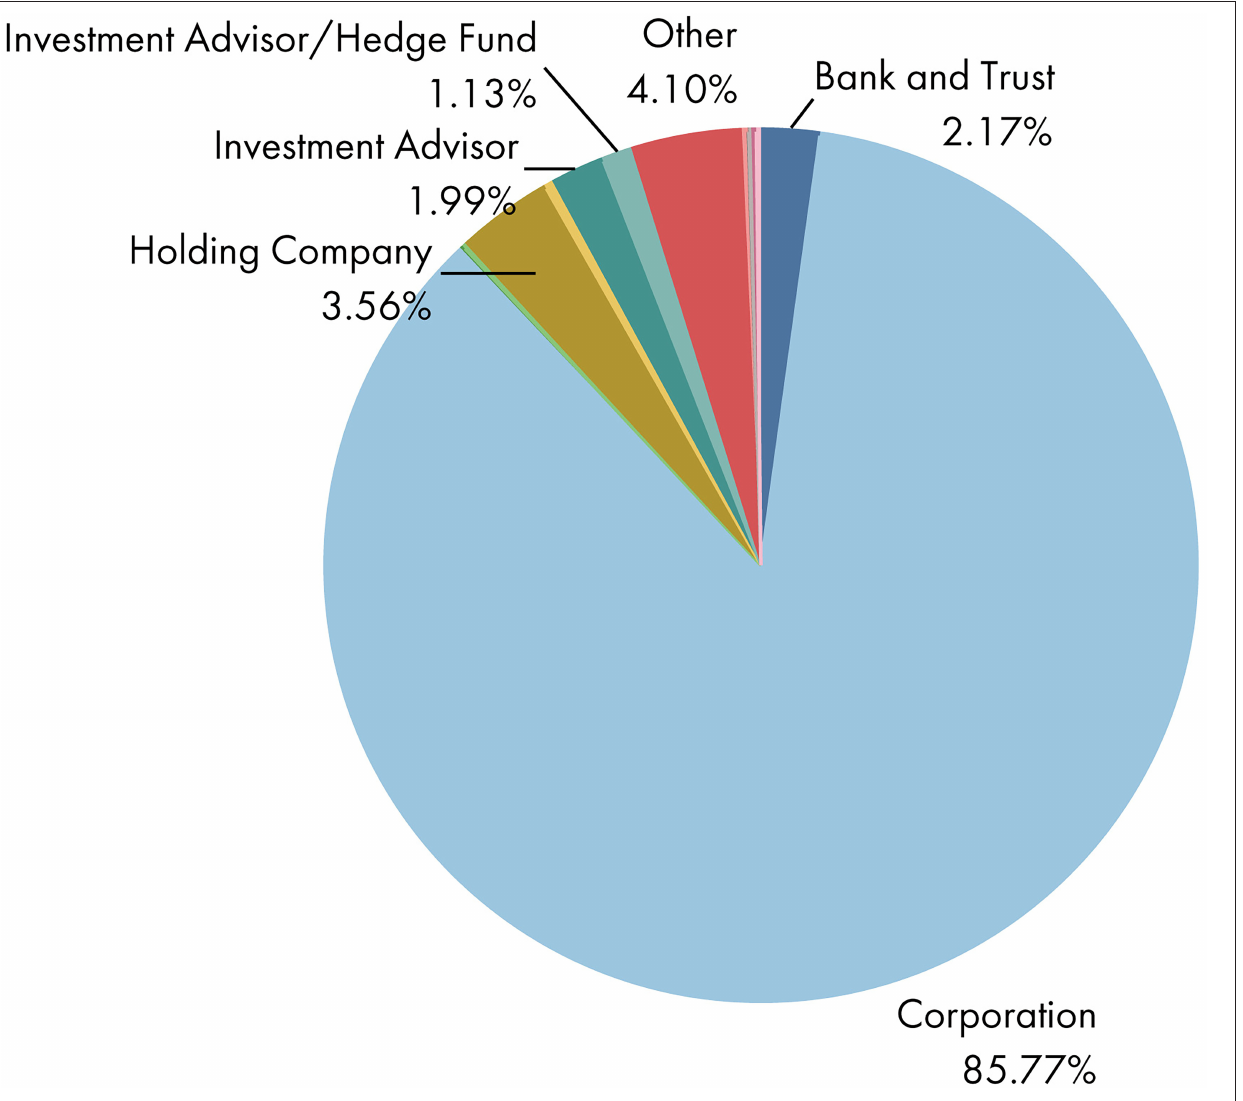
FIGURE 5 | Share of the ultimate ESG ownership by the investor